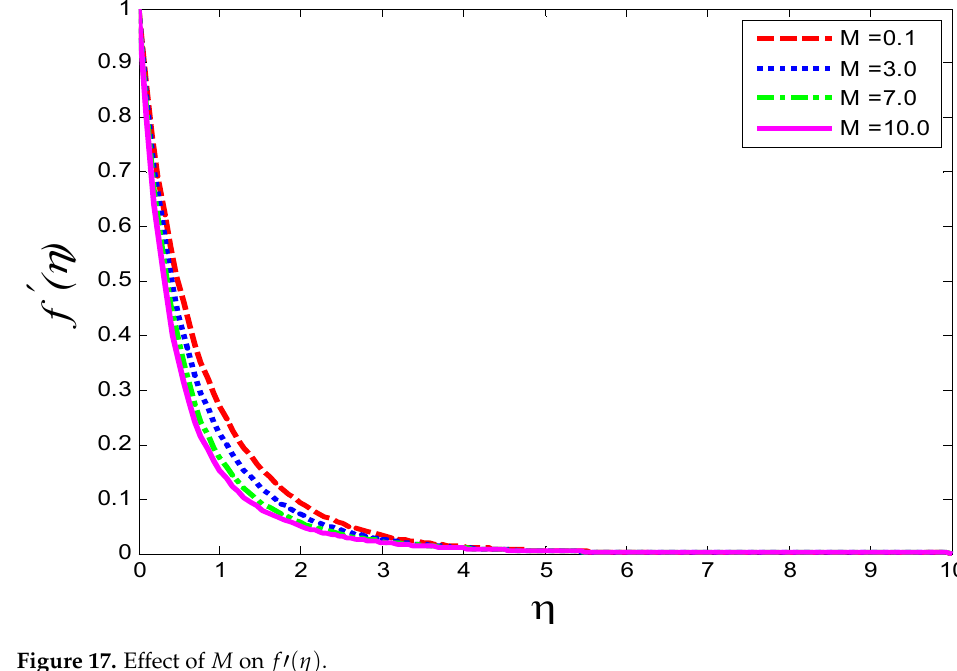
Figure 17. Effect of M on f (cid:48) ( η ) .